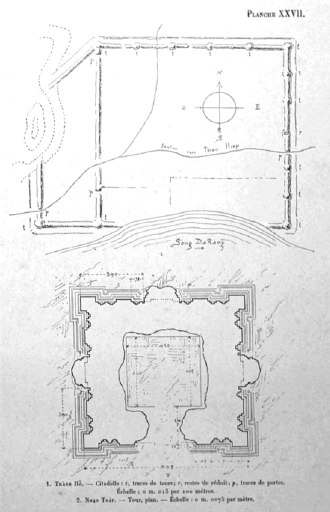
Figure 1. H ồ Citadel ( top ) and Nh ạ n Tower ( bottom ) by Parmentier (1909b, Planche XXVII). According to Parmentier (1909a, pp. 137–38), the citadel was on the ‘left’ (north) bank of the Ð à R ằ ng River, 15 km from where the river delta flows into the South China Sea. The sides were generally square, at 600 m each. There was also a second section (west) that